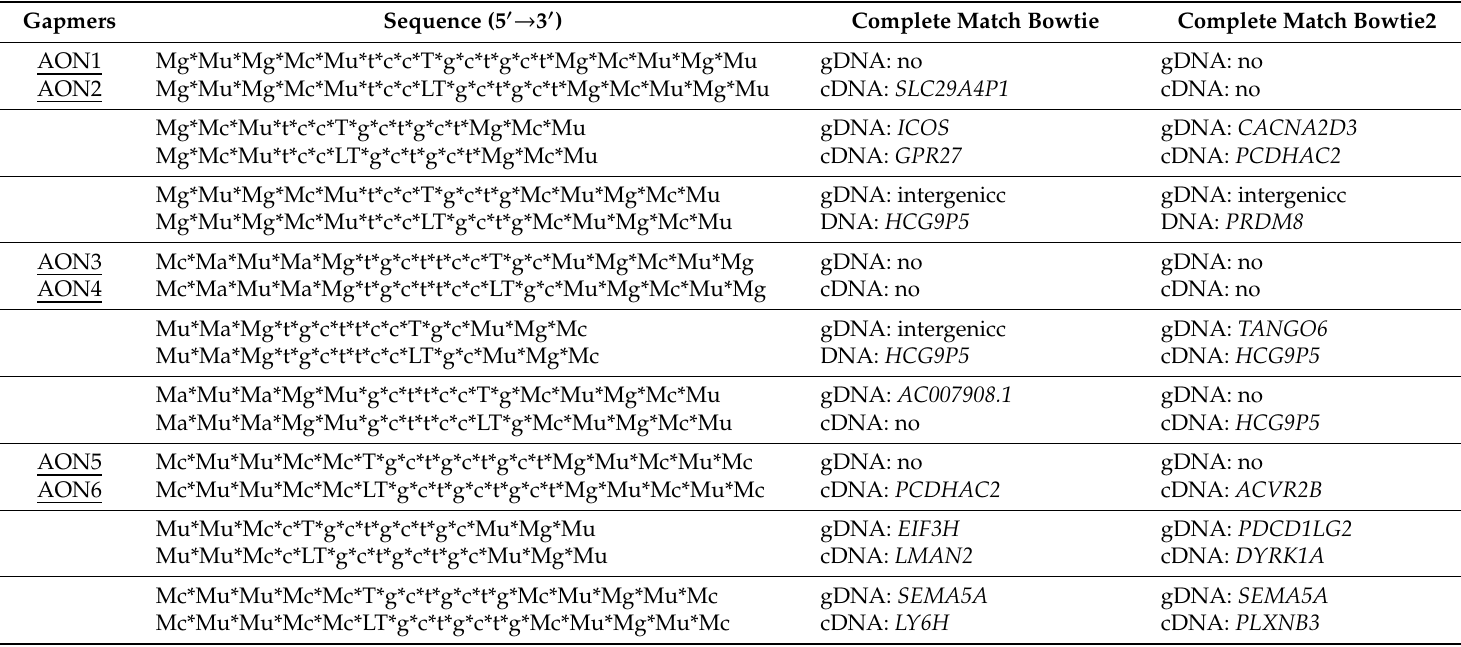
Table 1. Antisense oligonucleotide (AON) sequences and potential o ff targets. Underlined AONs were selected, as they do not have predicted o ff targets at the genomic DNA (gDNA) level. cDNA = complementary DNA, M = 2- O -Methyl modification, L = locked nucleic acid modification, * = phosphodiesterase bond. The site of the mutation is indicated with a capital